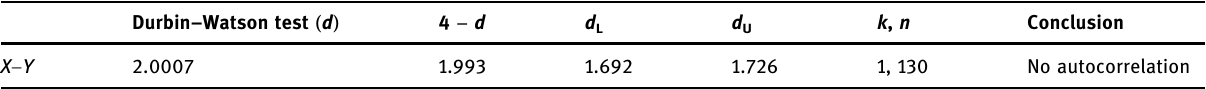
Table 5: The summary of autocorrelation test Durbin – Watson test ( d )